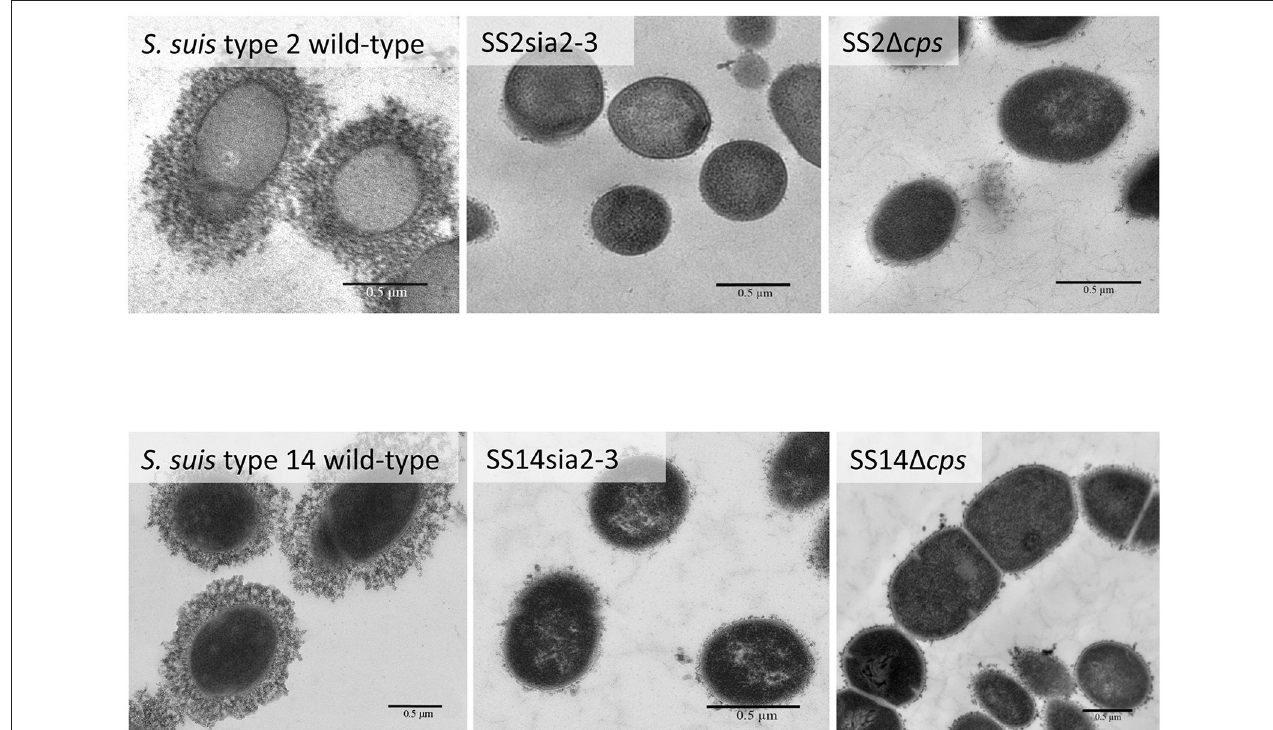
FIGURE 6 | Transmission electron micrographs showing capsular polysaccharide (CPS) expression by S. suis serotype 2 and 14 isogenic mutants. The CPS was labeled with polycationic ferritin. S. suis serotype 2 wild-type strain and S. suis serotype 14 wild-type strain were surrounded by a thick capsule, whereas the SS2sia2,3 ( 1 cps2N / cpsK ) and the SS14sia2,3 ( 1 cps14N / cpsK ) were non-encapsulated. Non-encapsulated mutant strains SS2 1 cps and SS14 1 cps were included as negative controls. Bars = 0.5 µ